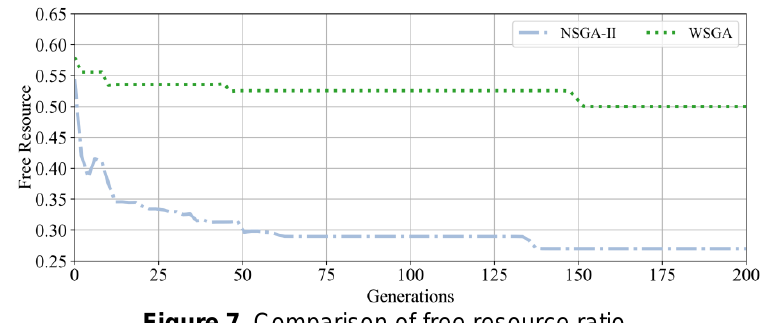
Figure 7 . Comparison of free resource ratio